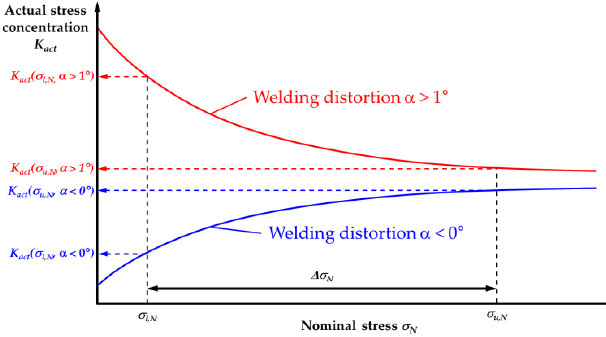
Figure 17. Effect of the actual stress concentration on upper and lower stresses with respect to the nominal stresses.